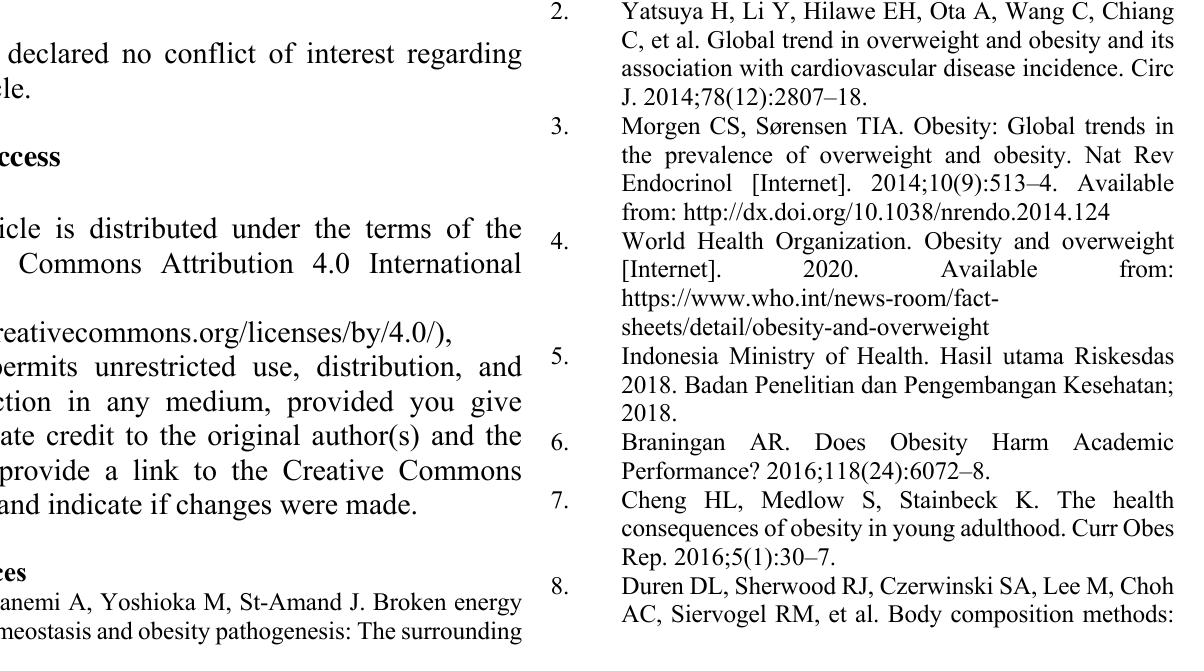
Table explanation: BMI: body mass index, BP: blood pressure, BW: body weight, FM: fat mass, FFM: fat free mass, HDL: high density lipoprotein, IF: intermittent fasting, LDL: low density lipoprotein, NS: not significant, TG: triglyceride, *reference number